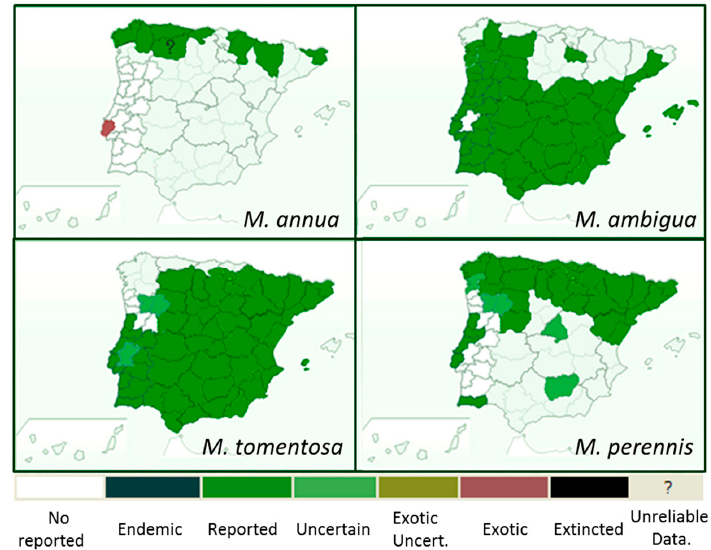
Figure 1. Distribution of Mercurialis annua, Mercurialis ambigua, Mercurialis tomentosa, and Mercurialis perennis in the Iberian Peninsula (https://www.bioscripts.net/).